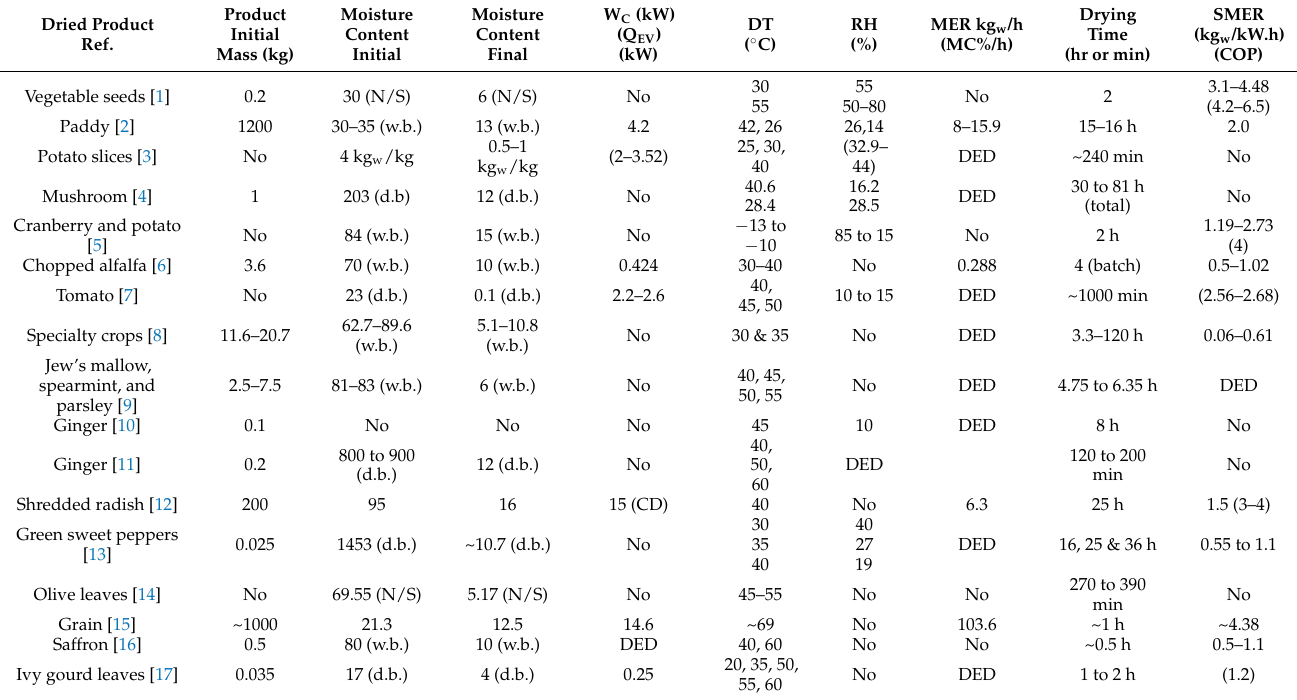
Table 1. A summary of experimental investigations on HPD systems for